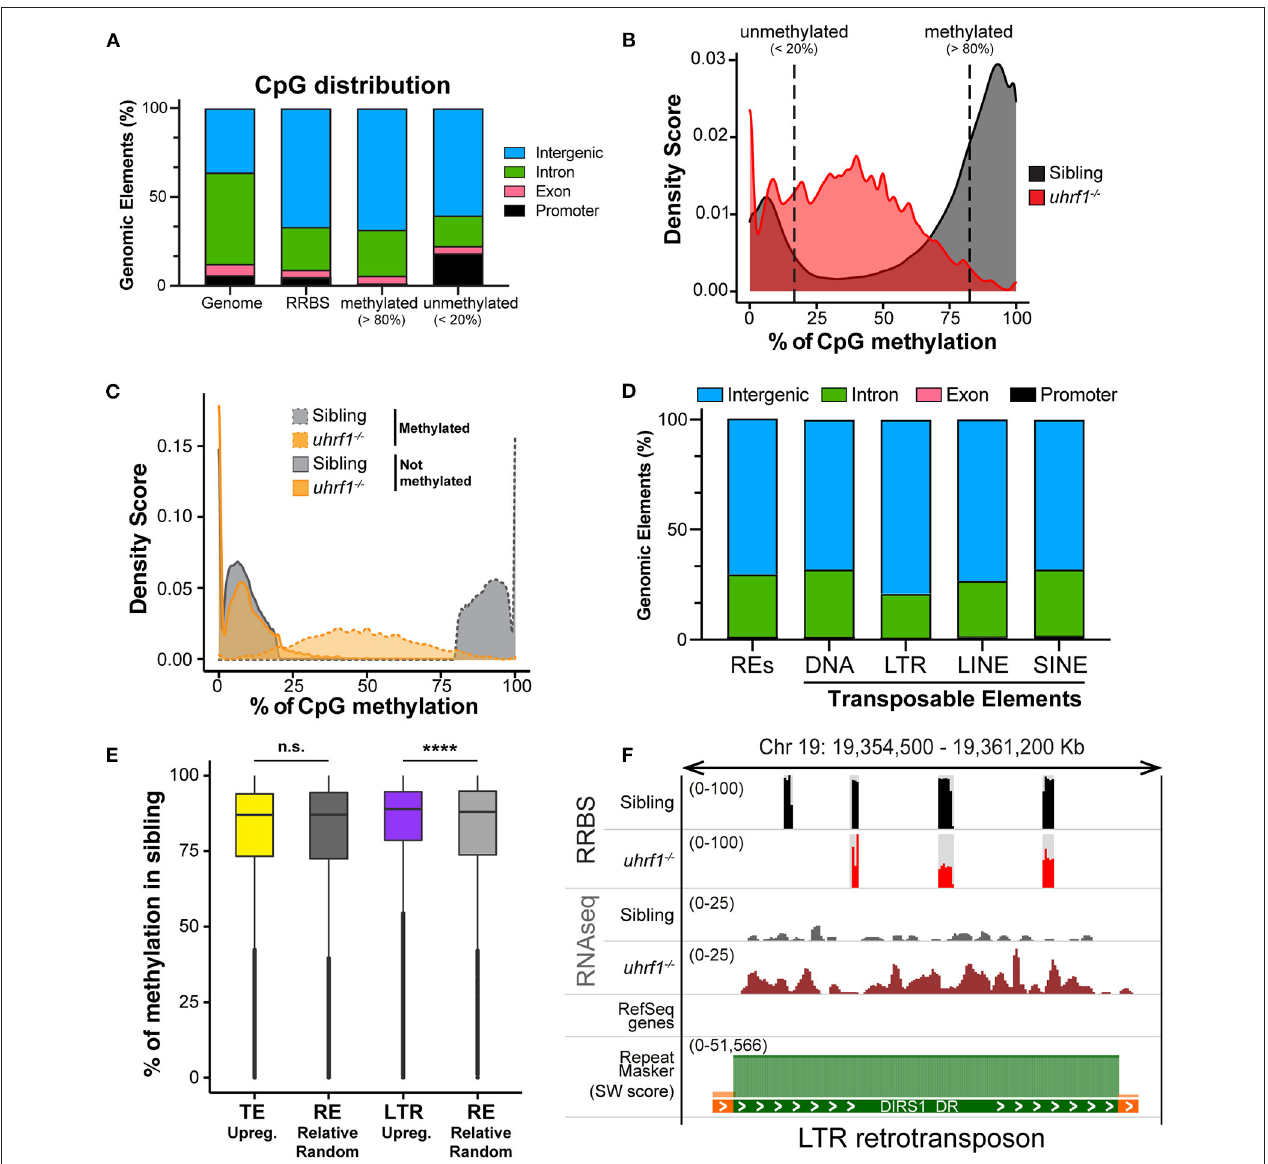
FIGURE 3 | DNA methylation is enriched on TEs that become activated in uhrf1 mutants. RRBS analysis on genomic DNA of TEs in uhrf1 − / − mutant larvae. (A) Genomic Annotation of all CpGs common to the unified dataset from uhrf1 − / − mutants and WT siblings are divided by level of methylation in WT siblings in methylated ( > 80%; 616,305 CpGs) and unmethylated ( < 20%; 212,750 of CpGs) and were then classified based on their location in annotated genomic element. (B) Density plot of percentage of methylation of CpGs in uhrf1 − / − mutants and wild-type siblings. (C) Density plot CpGs in uhrf1 − / − mutants and wild-type sibling. CpGs were classified based on the percentage of methylation in the sibling in methylated ( > 80%) (dashed gray line) and not methylated ( < 20%) (solid gray line). For each group, methylation levels were plotted for both mutants (dashed orange line) and siblings (solid orange line). (D) Genomic annotation of CpGs covered in RRBS and overlapping with the TEs annotated in the RNAseq. (E) Box plot describing the percentage of methylation of CpGs in WT siblings: from left, CpGs contained in TEs upregulated ( p adj < 0.05 and log 2 fold change > 0 in uhrf1 − / − mutants–yellow) and in equal number of REs randomly selected (193,397 regions–dark gray); CpGs contained in LTRs upregulated ( p adj < 0.05 and log 2 fold change > 0 in uhrf1 − / − mutants–purple) and in equal number of REs randomly selected (30,353 regions–gray). **** p < 0.0001 calculated by unpaired non-parametric Mann–Whitney test. (F) Genome browser screenshot shows an example of RNA transposons (LTR retrotransposon, DIRS1_DR) that is demethylated and expressed in uhrf1 − / − mutants. SW score is determined by Repeat Masker and it is used as indicator of the age of transposons. High SW score corresponds to highly conserved TEs, indicating younger